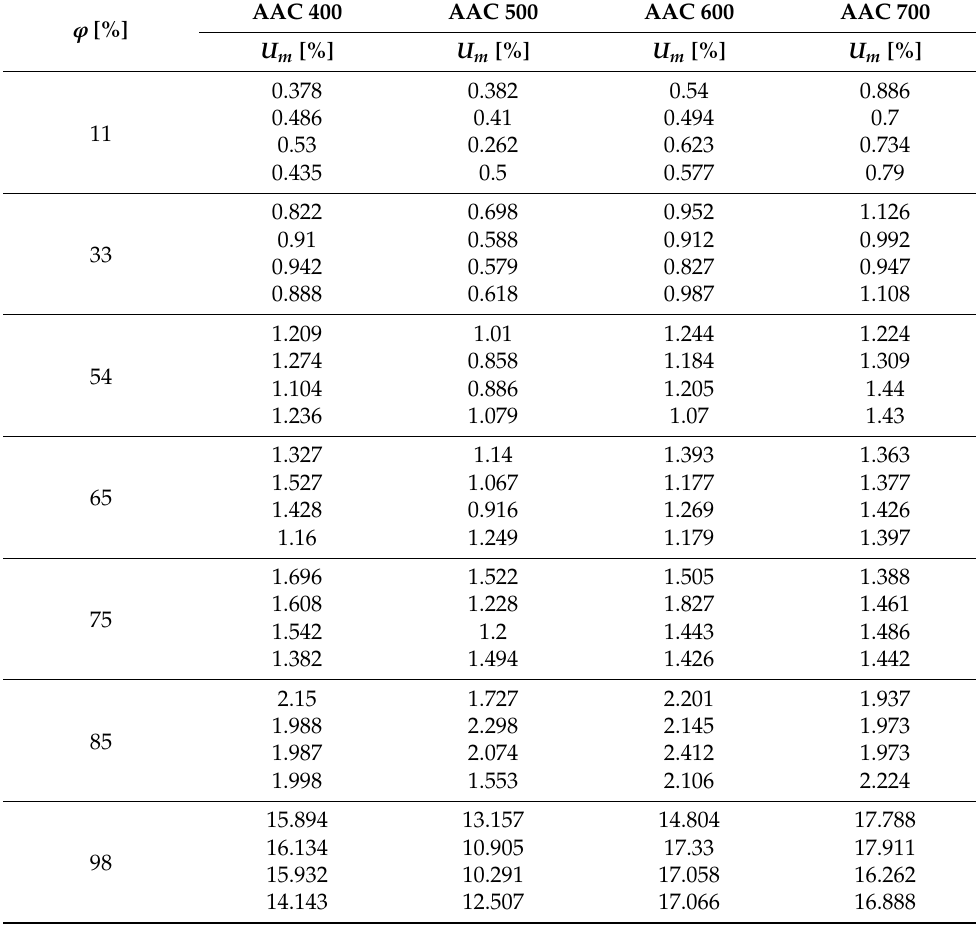
Table 3. Stabilized sorption moisture content U m of the autoclaved aerated concretes of classes 400, 500, 600, and 700